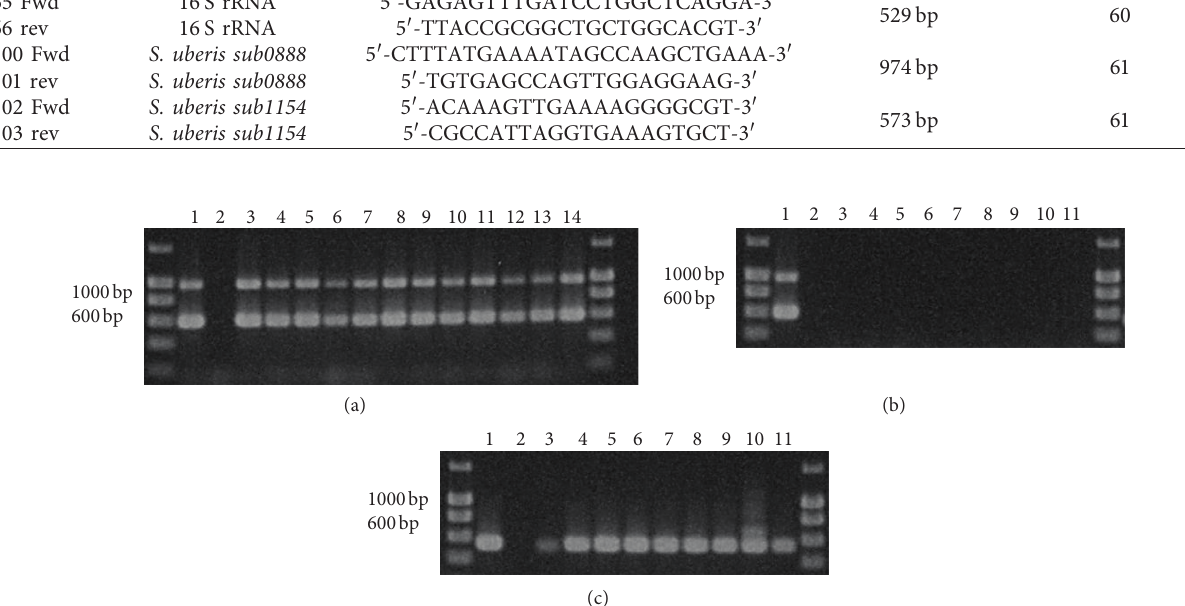
Figure 1: Multiplex PCR for S. uberis detection. (a) Detection of sub0888 and sub1154 in S. uberis strains EF20, 6736, 6780, Ab71, B190, B362, C5072, C5388, C6344, C8329, C9359, S6261 (lanes 3–14), S. uberis 0140J and no template control in lanes 1 and 2, respectively. (b) Detection of sub0888 and sub1154 in other bacterial strains, E. coli P4, S. aureus M60, S. agalactiae 0247a and 0251, S. dysgalactiae 0154 and A1, L. garvieae 131016 (isolated from cases of clinical mastitis), E. faecium and S. pneumoniae TIGR4 in lanes 3–11, respectively, S. uberis 0140J and no template control in lanes 1 and 2, respectively. (c) Confirmation of presence of 16s rRNA in other bacterial strains, as analysed in Figure 1(b).